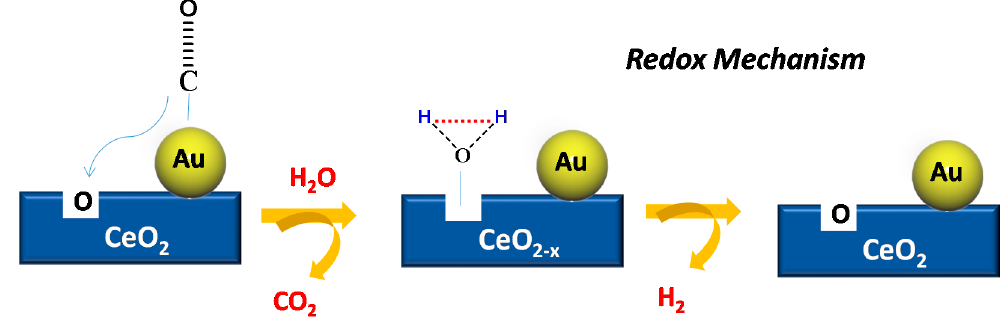
Figure 9. Simplified WGS redox mechanism for a model Au/CeO 2 catalyst.